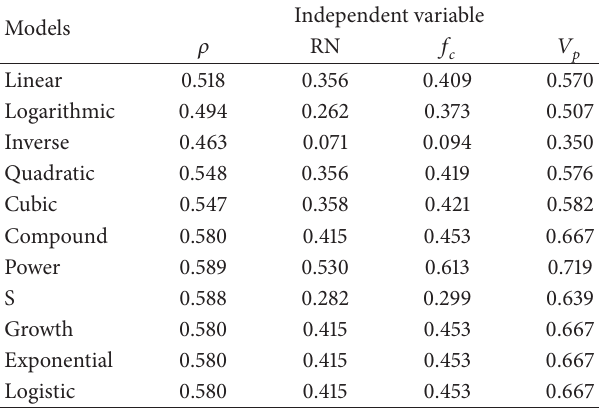
Table 3: Regression coefficient values for univariate nonlinear regression